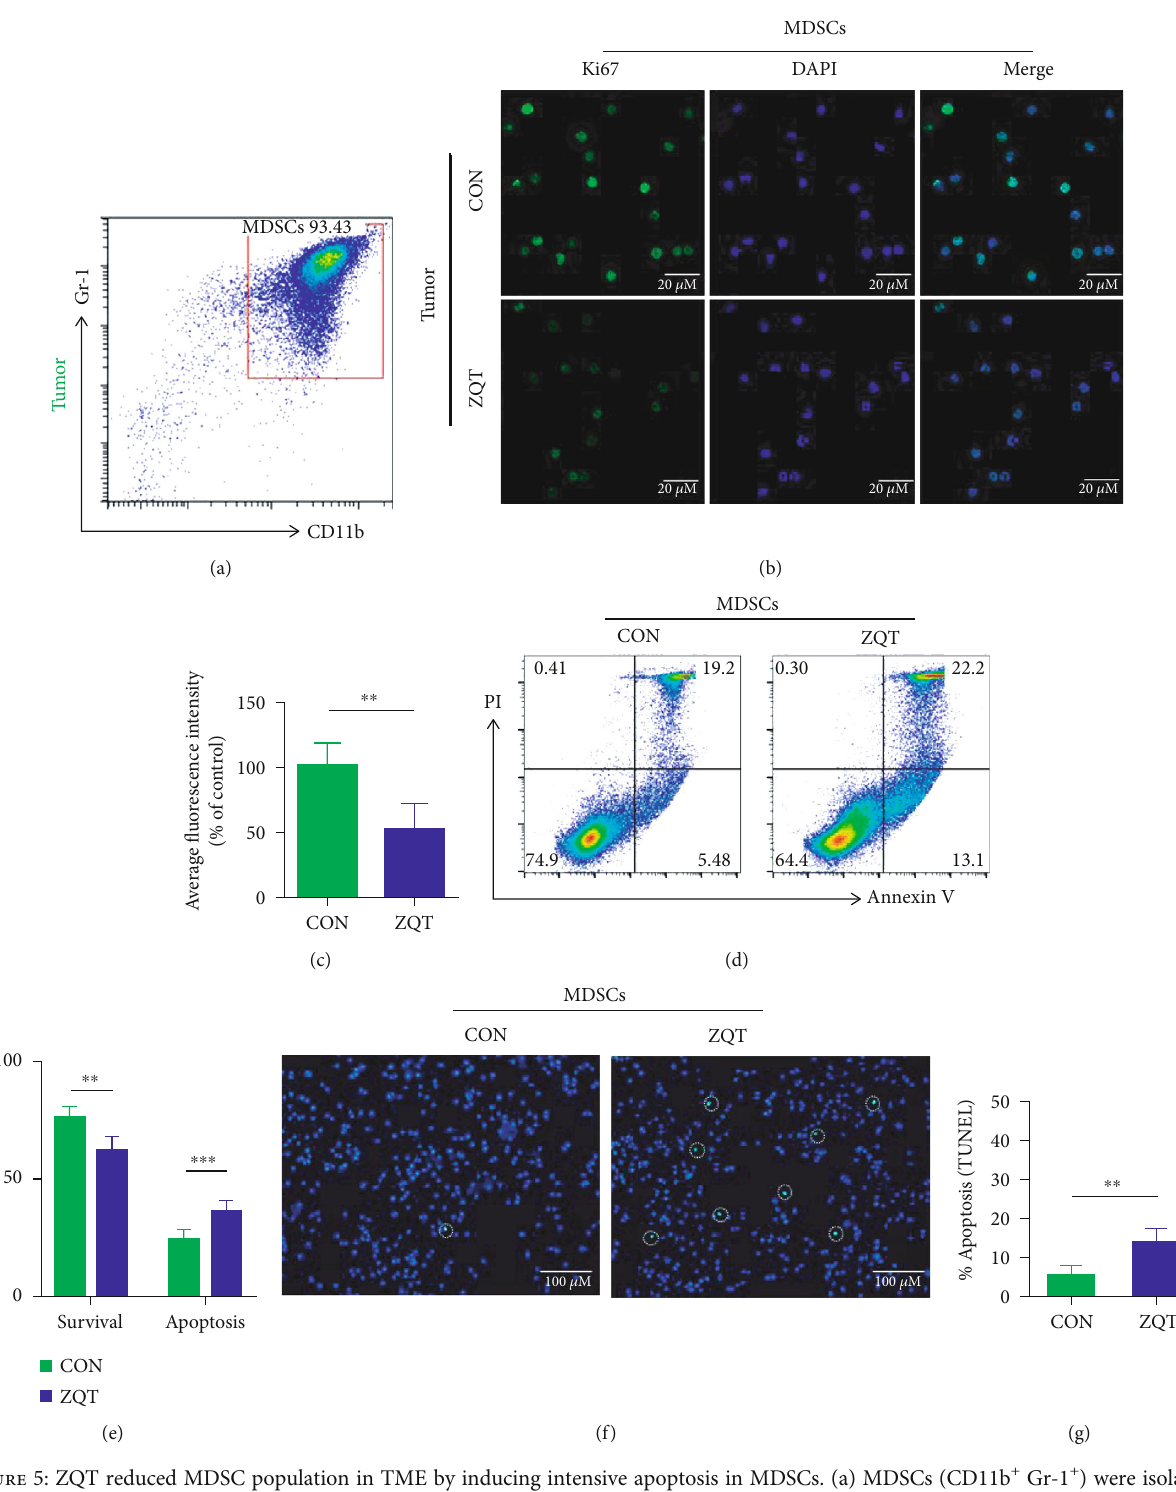
Figure 5: ZQT reduced MDSC population in TME by inducing intensive apoptosis in MDSCs. (a) MDSCs (CD11b + Gr-1 + ) were isolated from tumor tissue using the MojoSort Mouse Isolation Kit, and their purity was determined using fl ow cytometry analysis. (b, c) The proliferation of MDSCs isolated from ZQT or normal saline-treated tumor-bearing mice were detected by IF staining of Ki67 (scale bar: 20 μ M). (d) Representative apoptosis analysis of MDSCs isolated from tumor tissue by fl ow cytometry stained with Annexin V and PI. (e) Percentage of survival and apoptotic MDSCs isolated from normal saline or ZQT-treated mice. (f, g) TUNEL staining of MDSCs collected from tumor tissue (original magni fi cation: 200x). n = 5 . Data are expressed as the mean ± SD . ∗∗ p < 0 : 01 ; ∗∗∗ p < 0 : 001